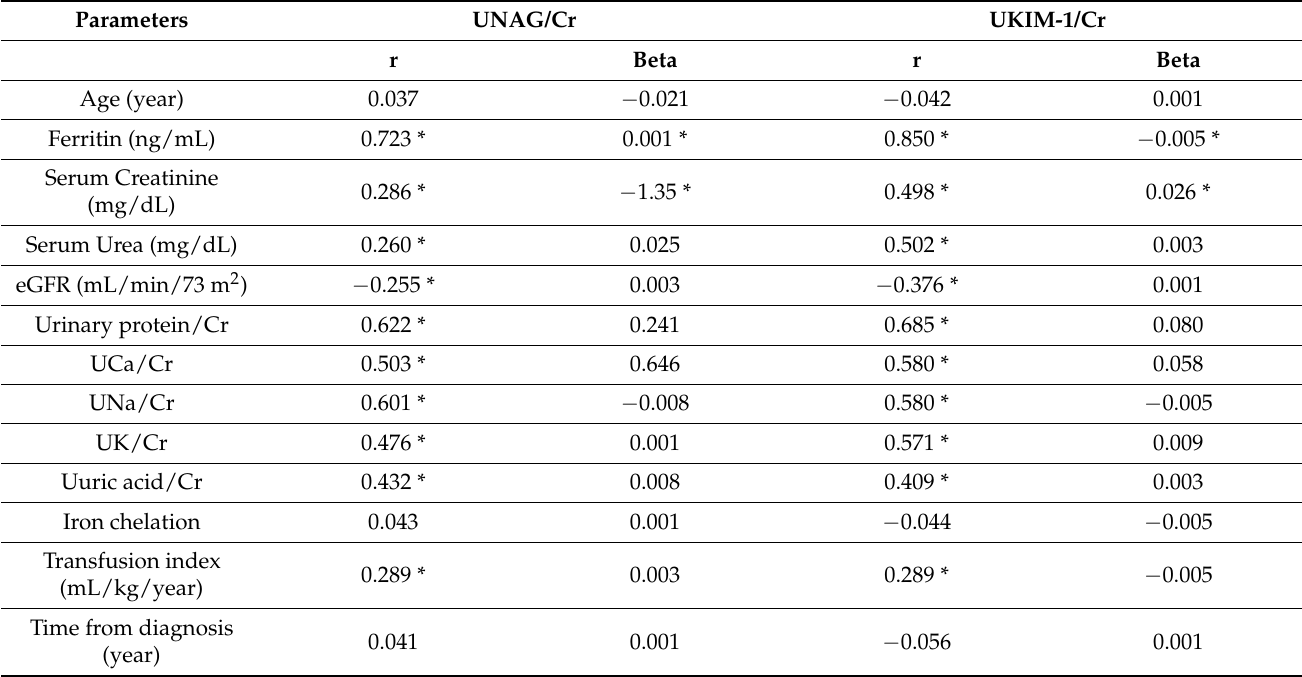
Table 5. Univariate correlation and multi-linear regression between UNAG/Cr or UKIM-1/Cr and other parameters among studied beta-TM patients.